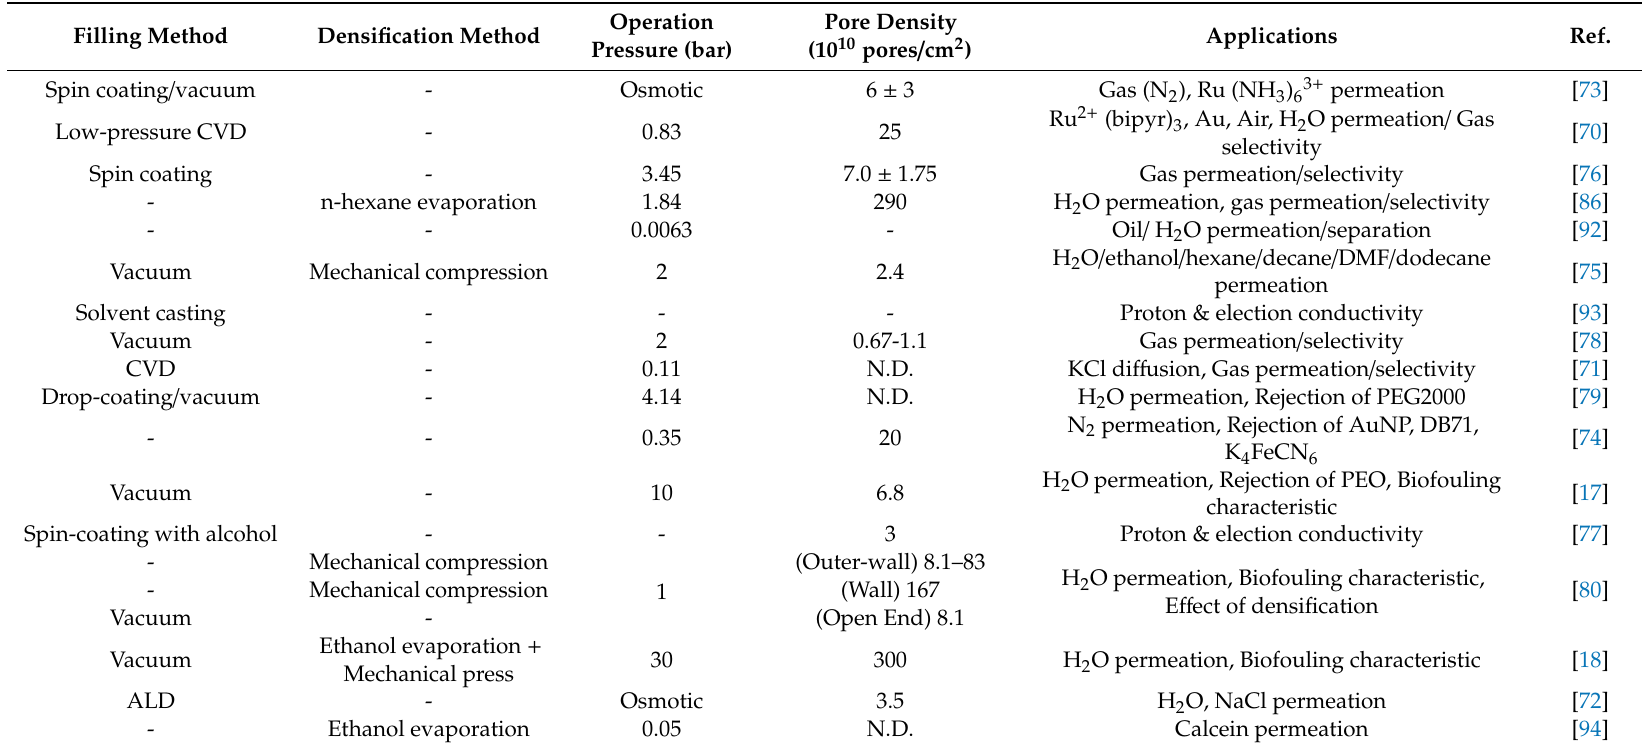
Table 3. Comparison of fabrication methods, pore density, and applications of vertically aligned carbon nanotube (VACNT)